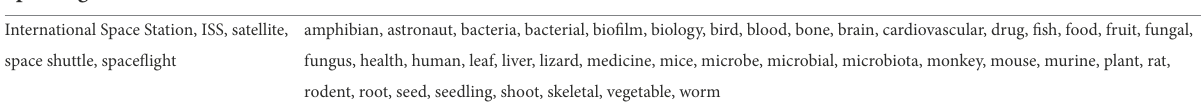
TABLE 2 List of key words searched in PubMed for finding space life investigations.